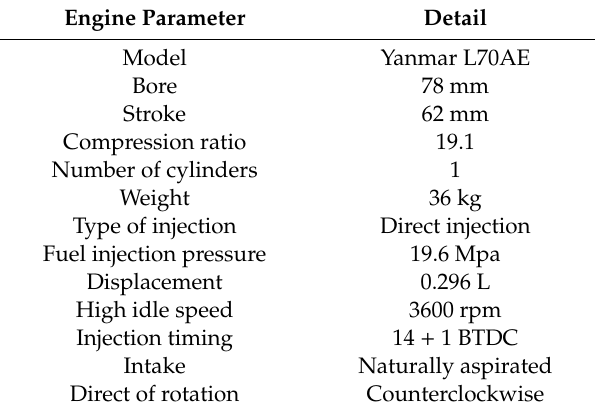
Table 1. Technical specifications of the Yanmar L70AE